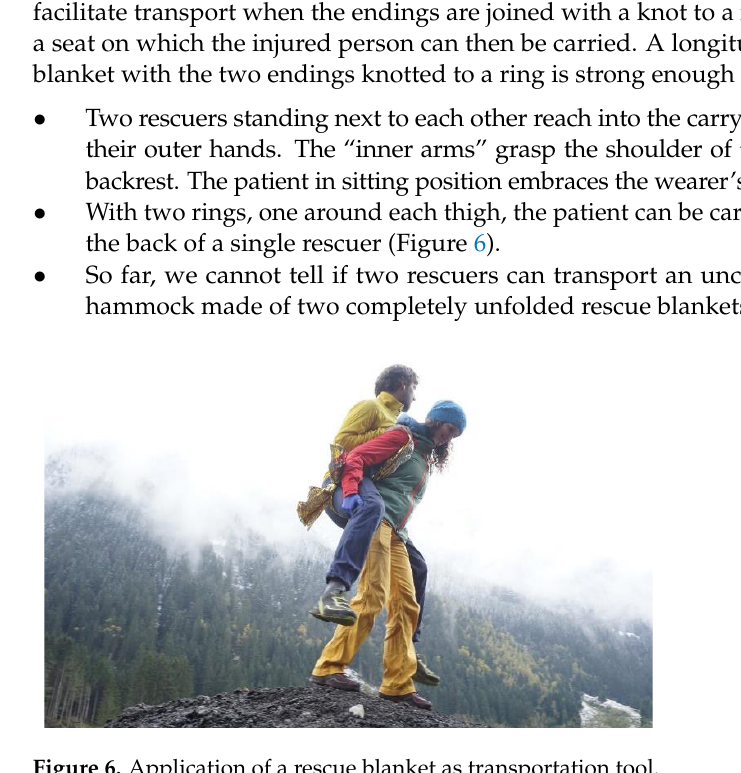
Figure 6. Application of a rescue blanket as transportation